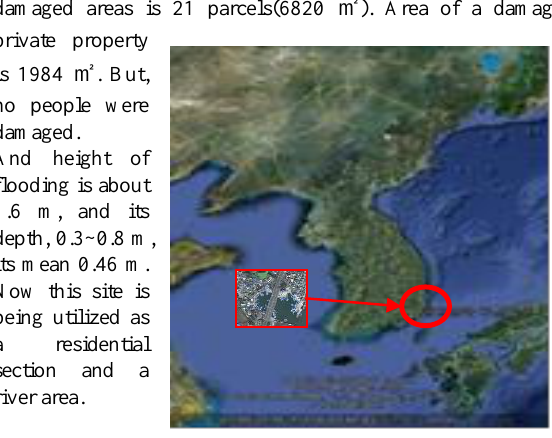
Figure 1. Test area (courtesy of Google)